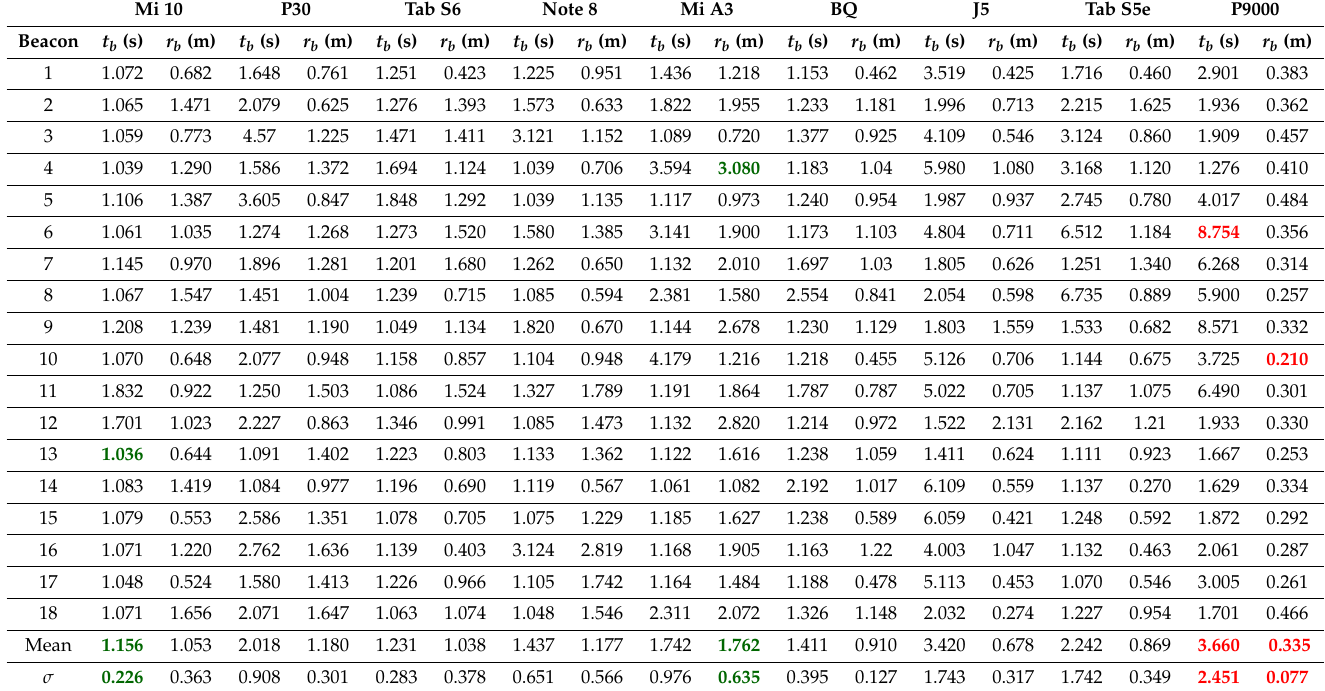
Table 1. Beacon detection time t b (s) and detection range r b (m) for each device and code. Each parameter’s best values are in bold green, and the worst values are in bold red.